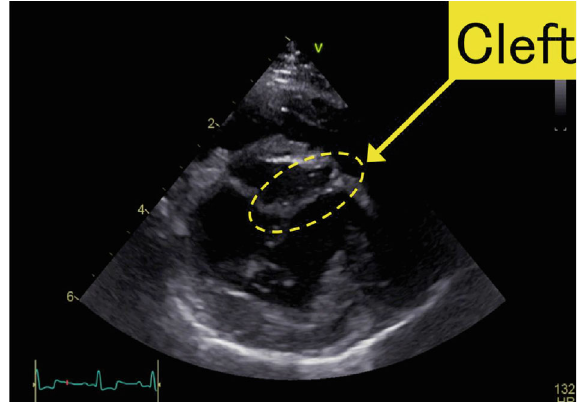
Figure 2: Two-dimensional echocardiography image. In the right parasternal short-axis view at the level of the mitral valve, a cleft is observed in the A2 segment of the anterior lea fl et of the mitral valve.